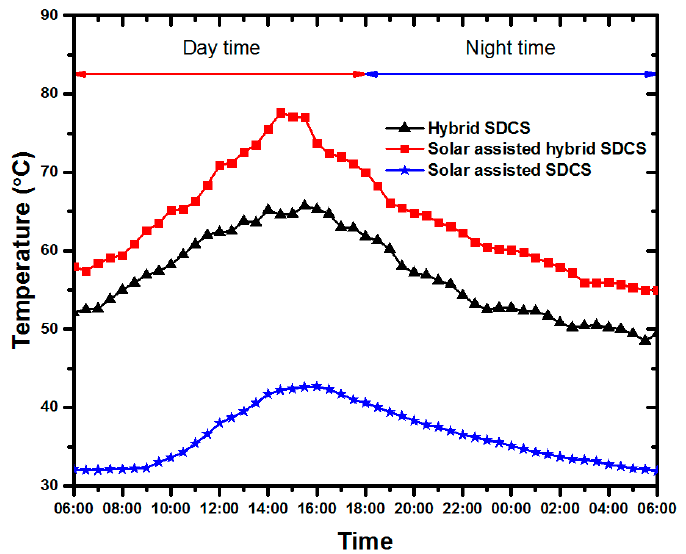
Figure 4. Comparison of regeneration temperature in each system configuration.